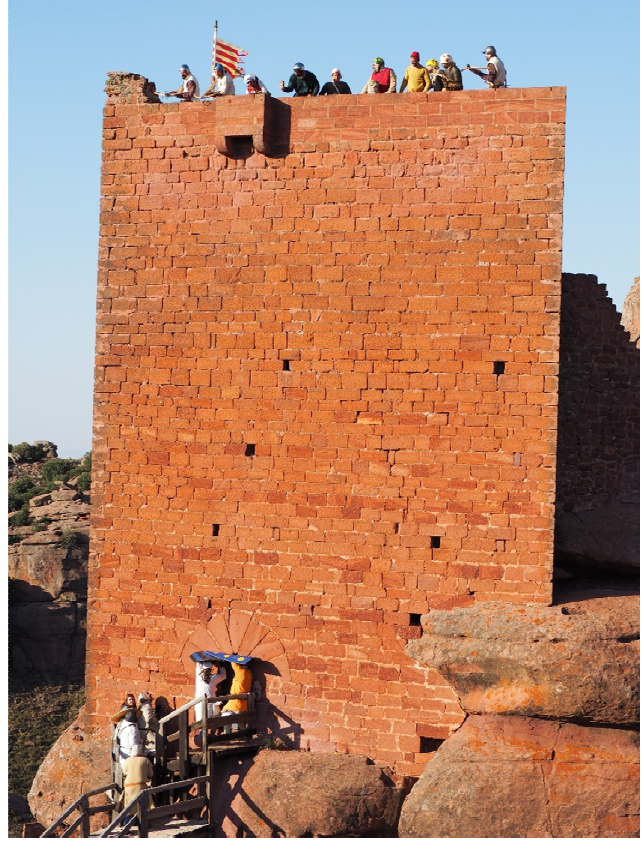
Figure 3. Peracense reenactment, Spain.